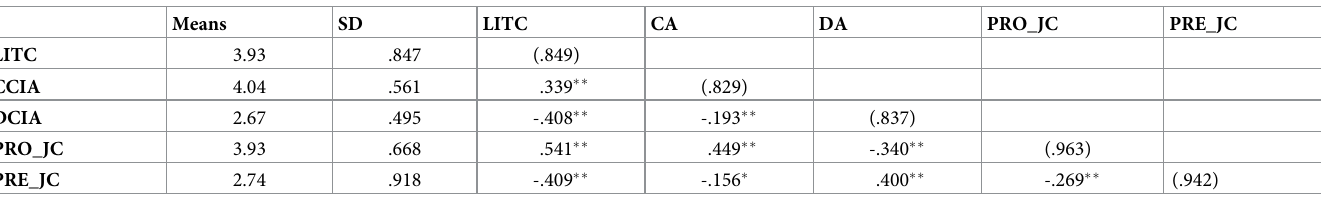
Table 2. Means, standard deviation and correlations